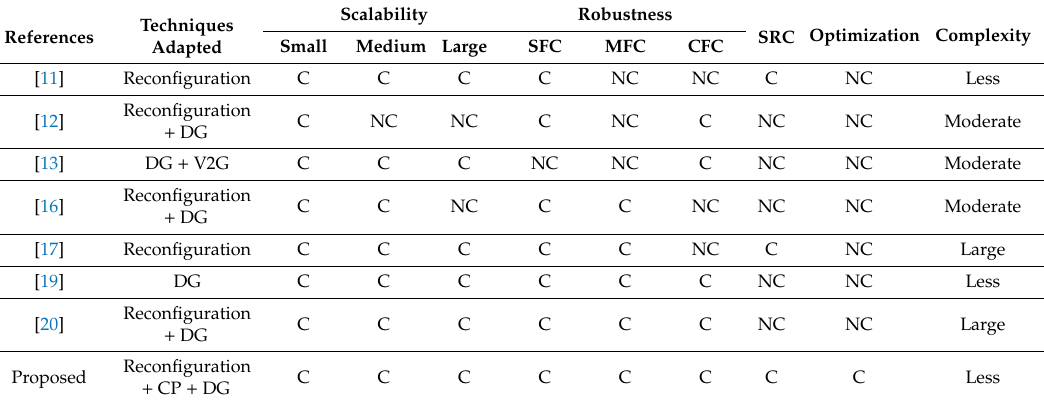
Table 1. Comparison of the